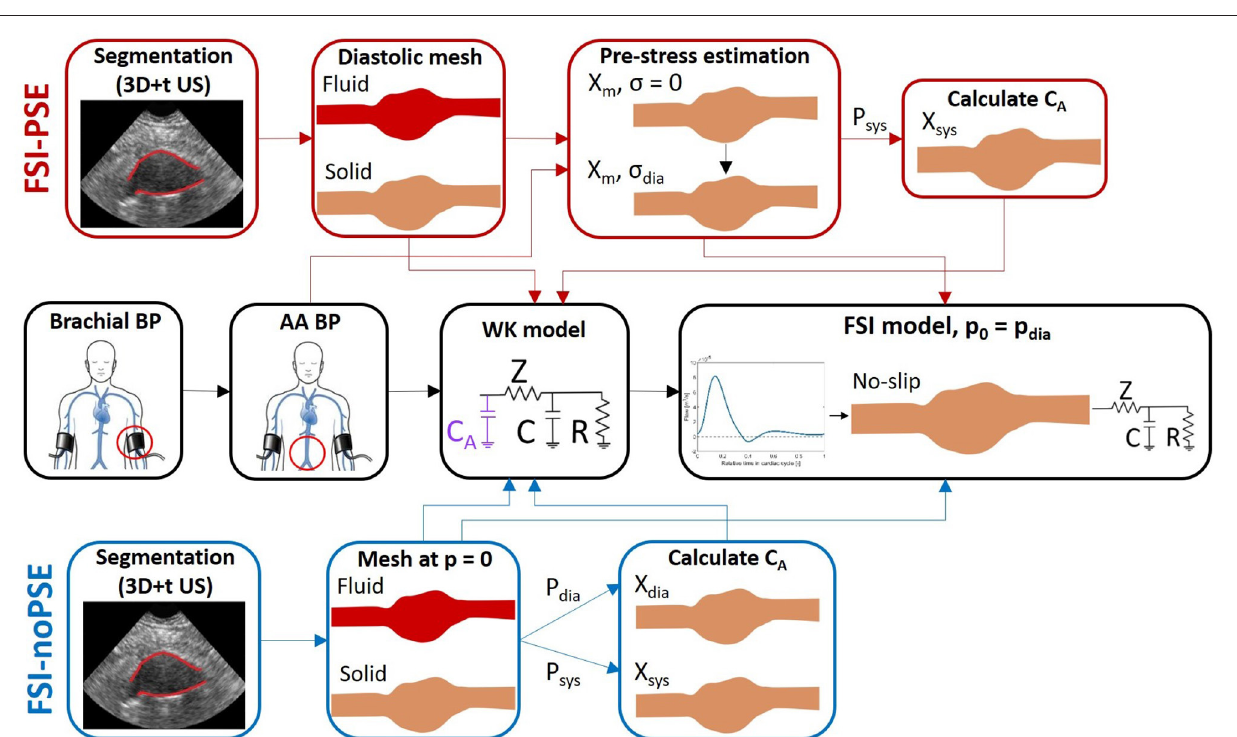
Figure 1 ). For each workflow, the 3D+t, US-based segmentation and brachial blood pressure (BP) were used as inputs to create the fluid and structural meshes and boundary conditions for the FSI models, respectively. The complete workflow will be discussed in the subsequent